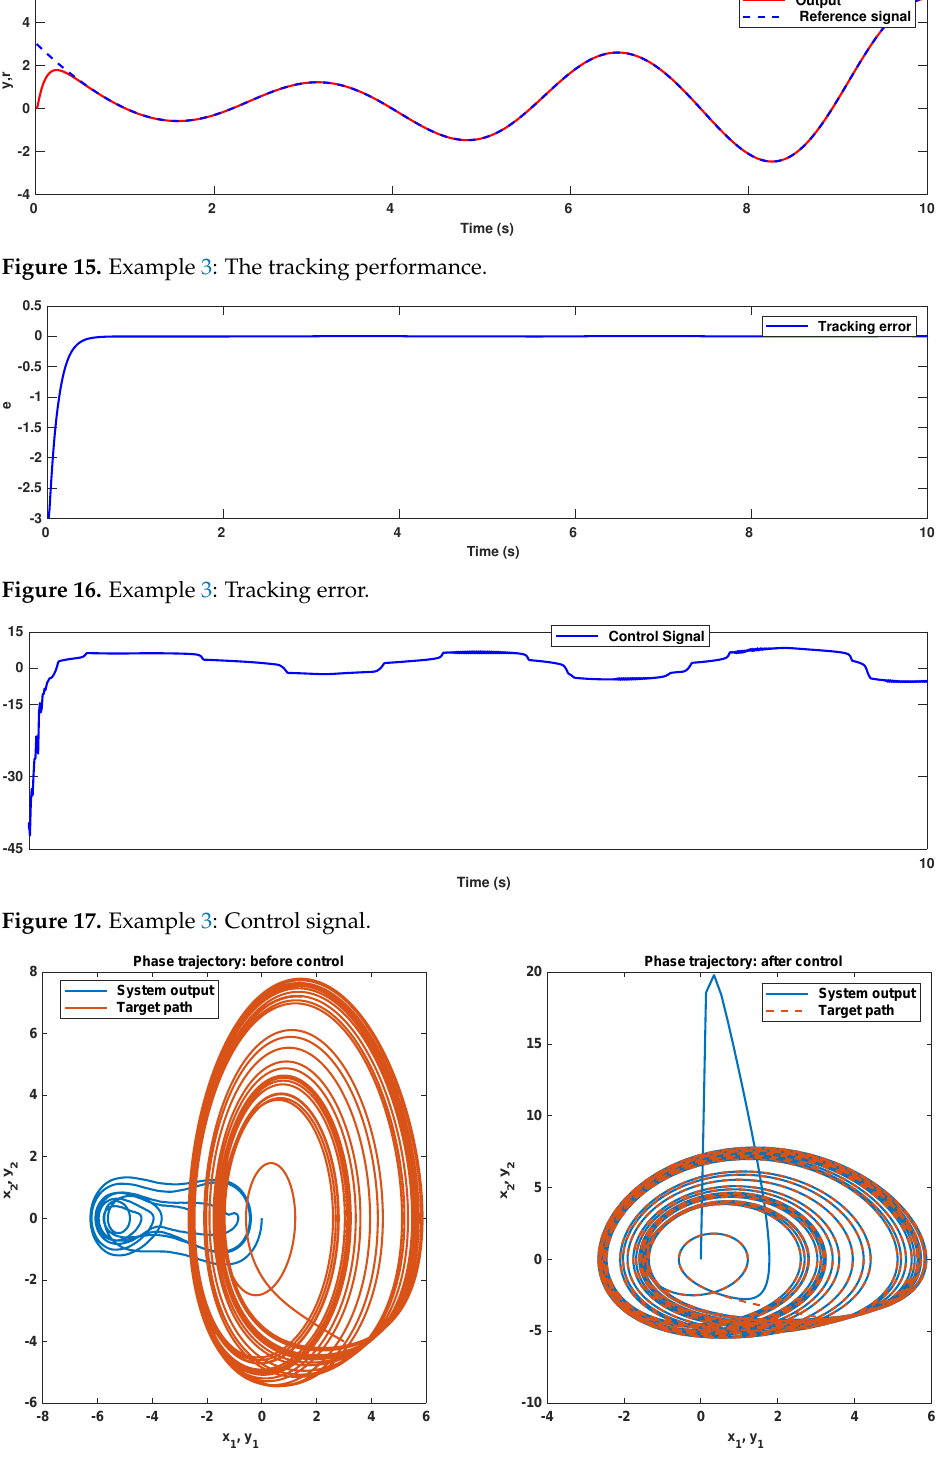
Figure 18. Example 3: Phase trajectory, after and before